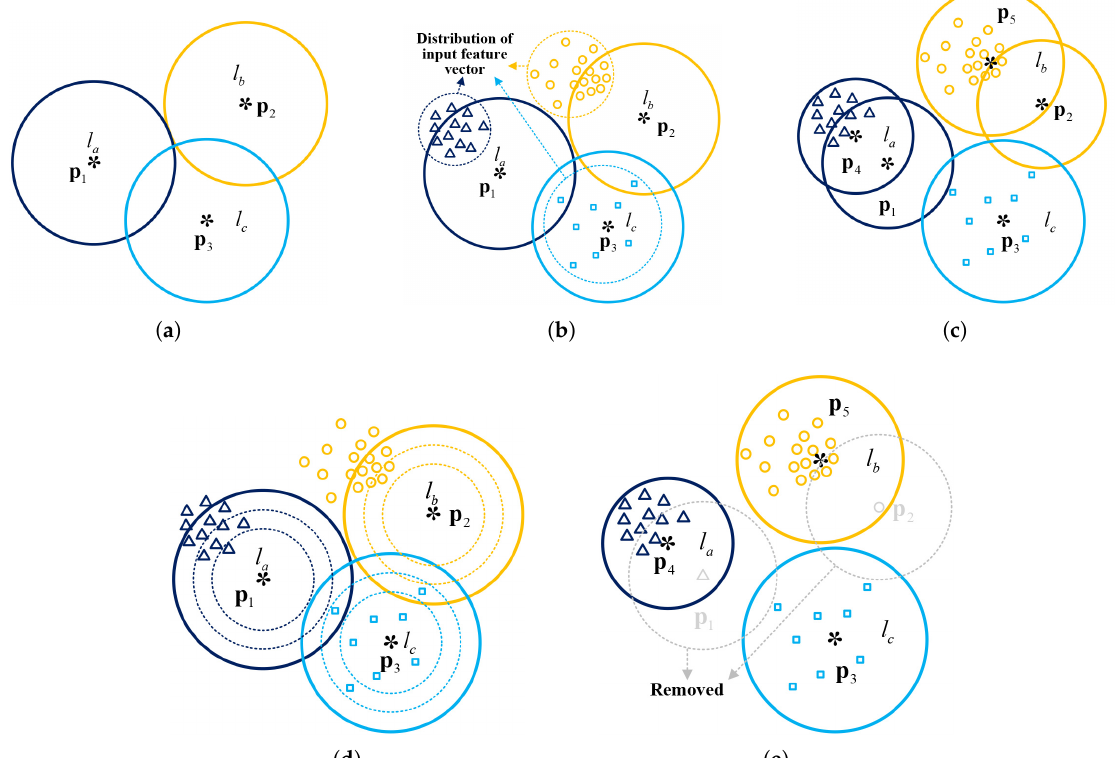
Figure 2. Learning process of hierarchical prototype learning (HPL)-RCE and the proposed RCE. ( a ) Example of 2D feature space learned with three feature vectors, ( b ) distribution of the feature vectors to be used in the learning process, ( c ) learning results of HPL-RCE, ( d ) division of the activation region as presented in the proposed learning algorithm, ( e ) learning results of the proposed